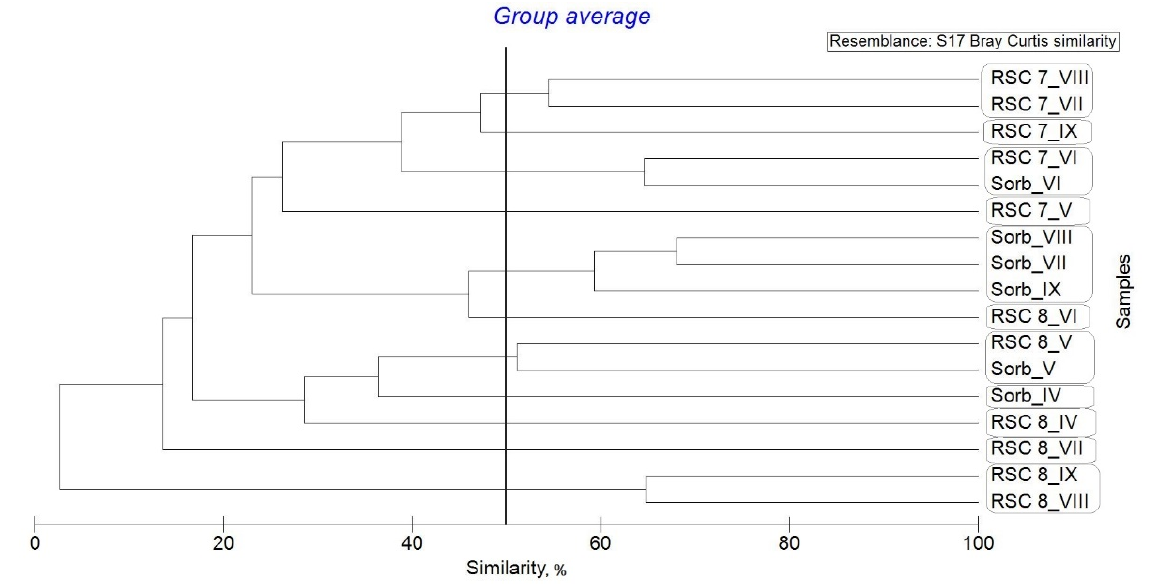
Figure 6. Similarity of species composition of zooplankton according to the Bray–Curtis coefficient in wastewater reservoirs of the Right-Bank Sorbulak Canal system during six warm months of 2021. Roman numerals represent the month: IV—April, V—May, VI—June, VII—July, VIII—August, IX— September.